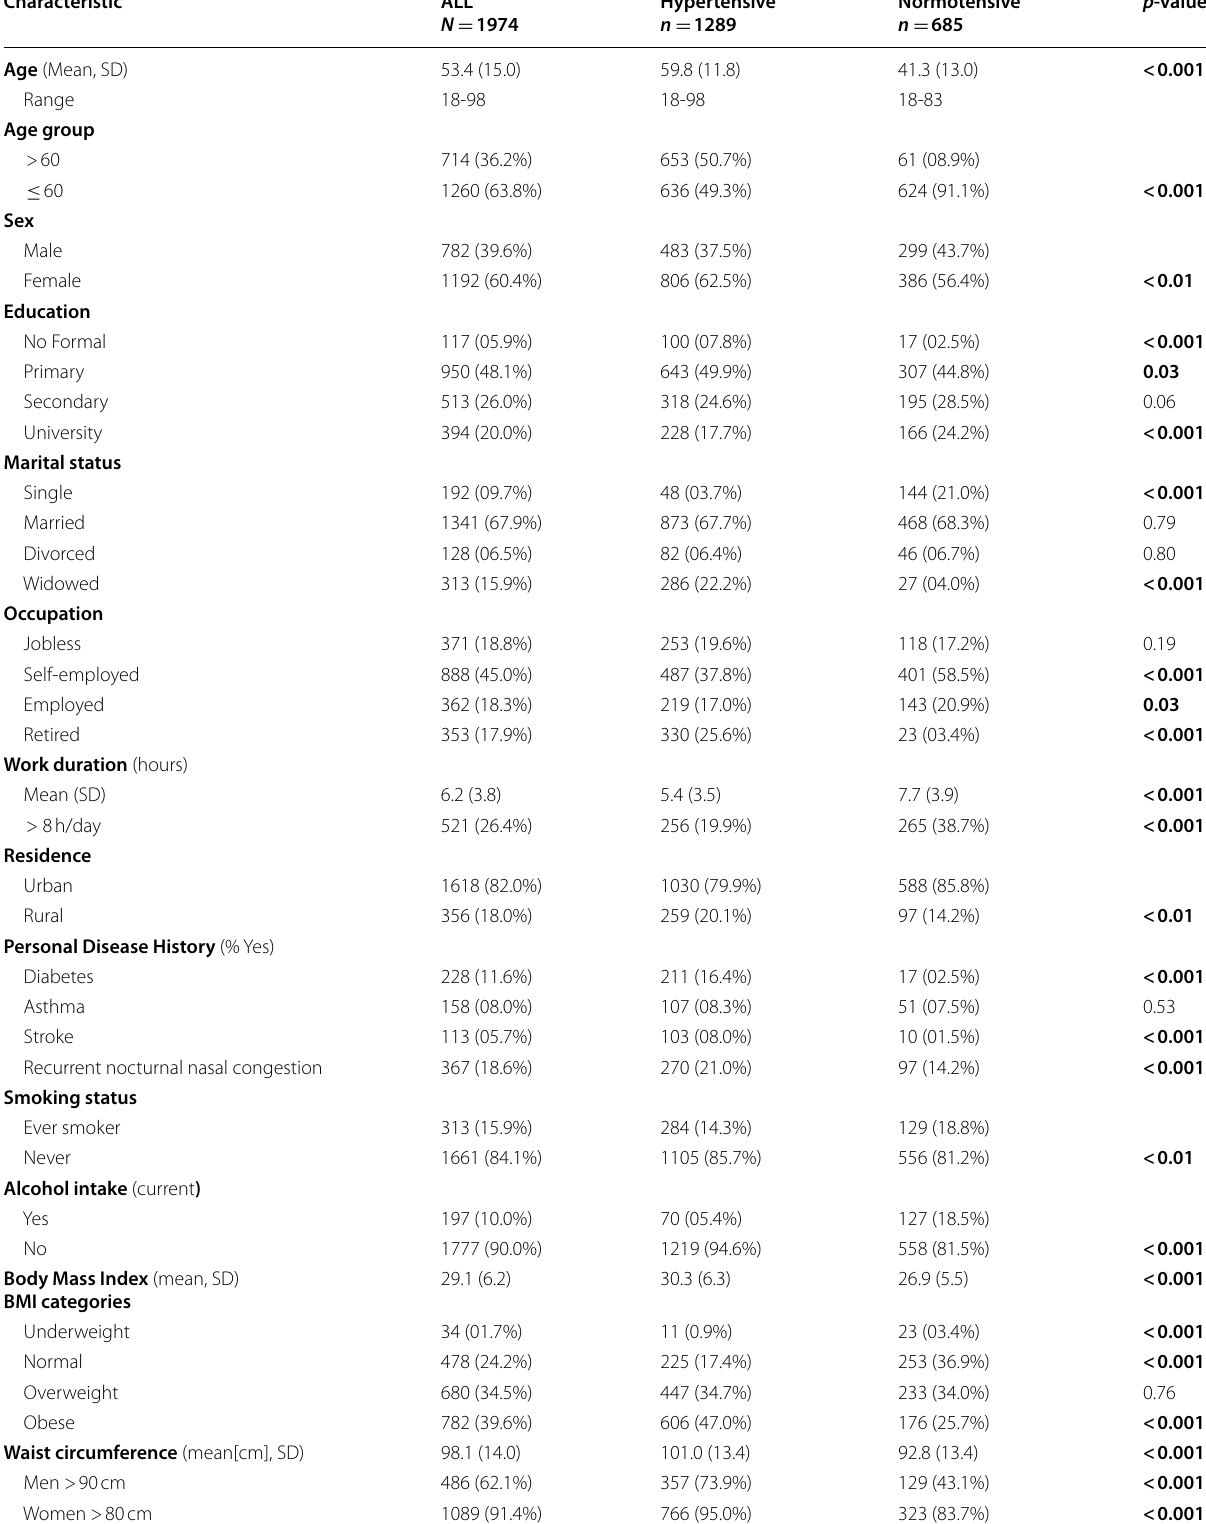
Table 1 Sociodemographic characteristics of study participants by hypertension status